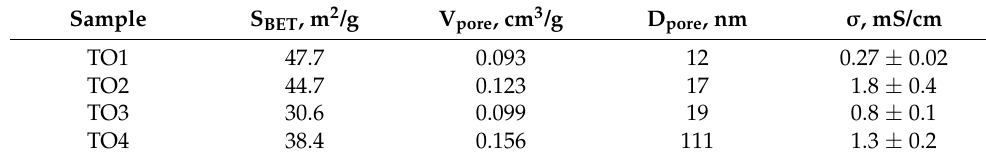
Figure 2. Mercury intrusion porosimetry data on pore volume ( A ) and pore size ( B ) distributions. Table 1. Physicochemical properties of SnO 2 samples obtained from SnCl 4 .